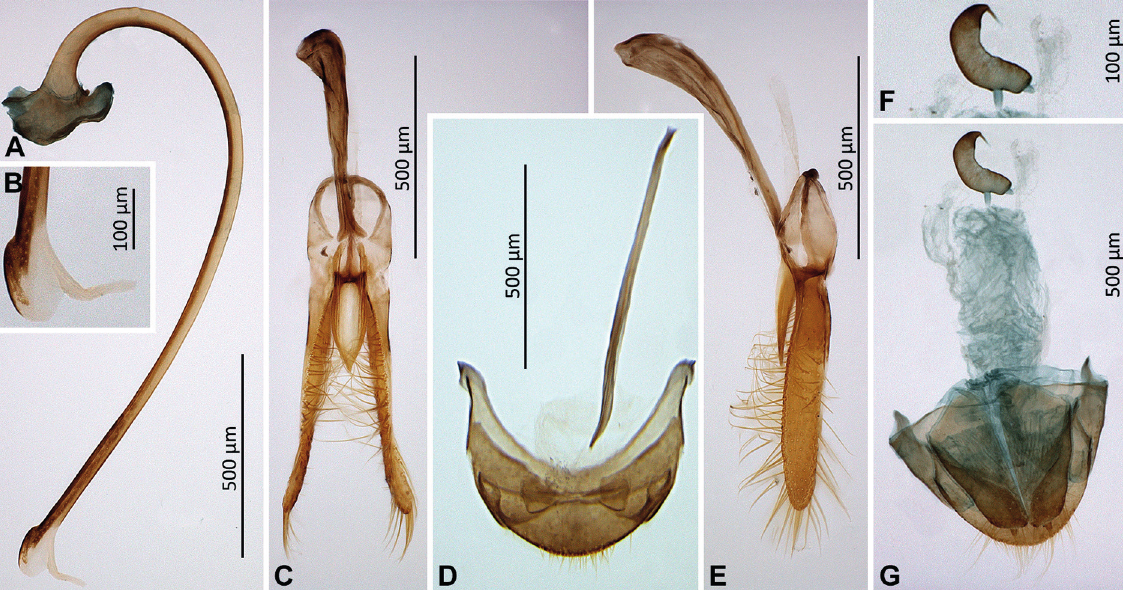
Fig. 9. Siola atra González, 2015 (MIZ). A . Penis, lateral view. B . Penis tip, lateral view. C . Tegmen, inner. D . ♂, segments IX and X, dorsal view. E . Tegmen, lateral view. F . ♀, spermatheca. G . ♀, genitalia, ventral